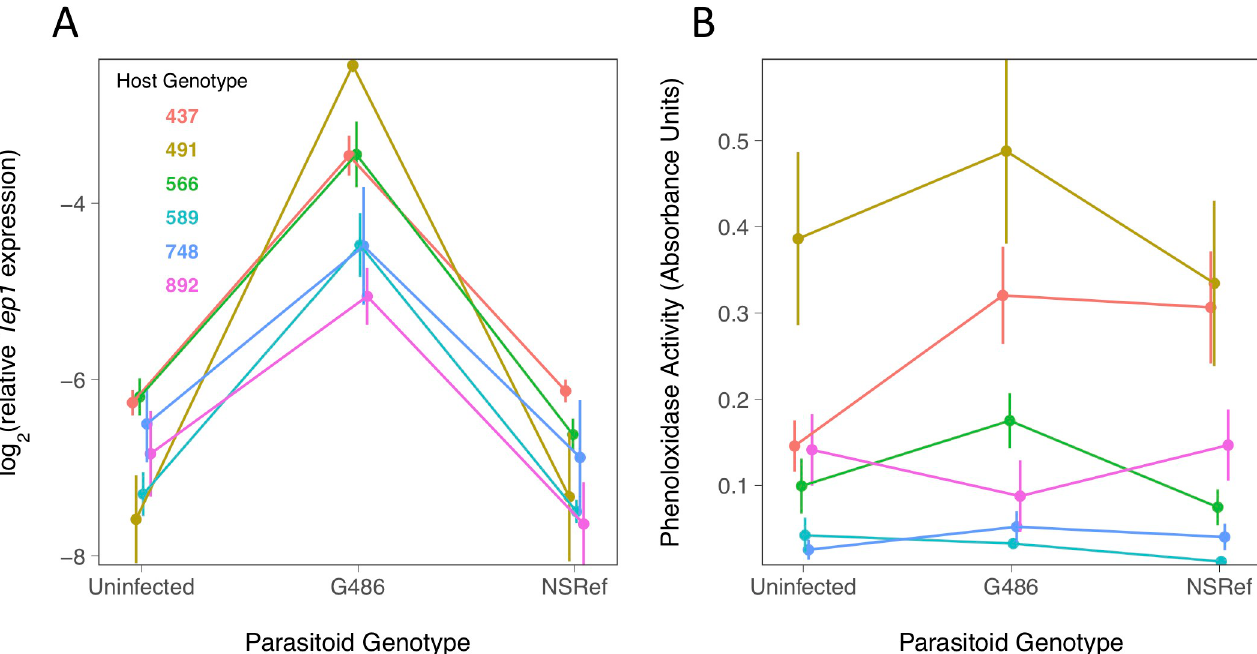
Fig 3. Humoral immune response of six Drosophila genotypes to two parasitoid genotypes. (A) Tep1 expression relative to RpL32 expression measured by quantitative PCR. (B) Phenoloxidase activity in the hemolymph of Drosophila larvae, measured by 490nm light absorbance due to conversion of L-DOPA into dopachrome. Larvae were incubated for 24h post infection in (A) and (B). Bars are standard errors. Each data point in panel A is estimated from 8 pools of 10 larvae and in panel B is from a mean of 10.6 pools of 20–25 larvae (details in S1 Table).